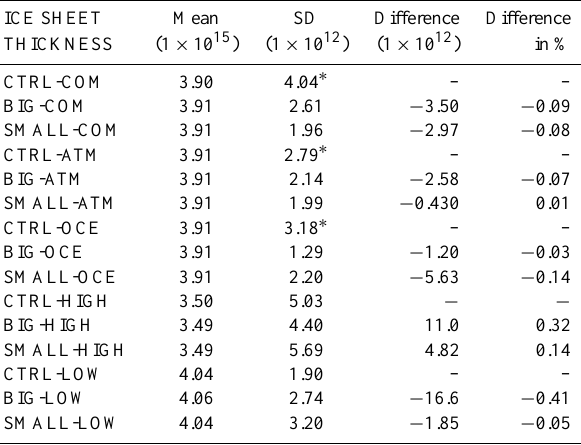
Table 3. Ice sheet volume (m 3 ) : mean and standard deviation of the last 100 years; the ∗ corresponds to the CTRL SD that was com- puted over the last 200 years to have a more representative range of internal variability as a reference; difference between the ice sheet volume of the CTRL experiment and the BIG/SMALL experiments in absolute numbers, if the value is above 2 · SD of the CTRL exper- iments ( ∗ ), then the difference is significantly different from internal variability (none of the experiments); % diff = difference between the ice sheet volume of the CTRL experiment and the BIG/SMALL experiments in